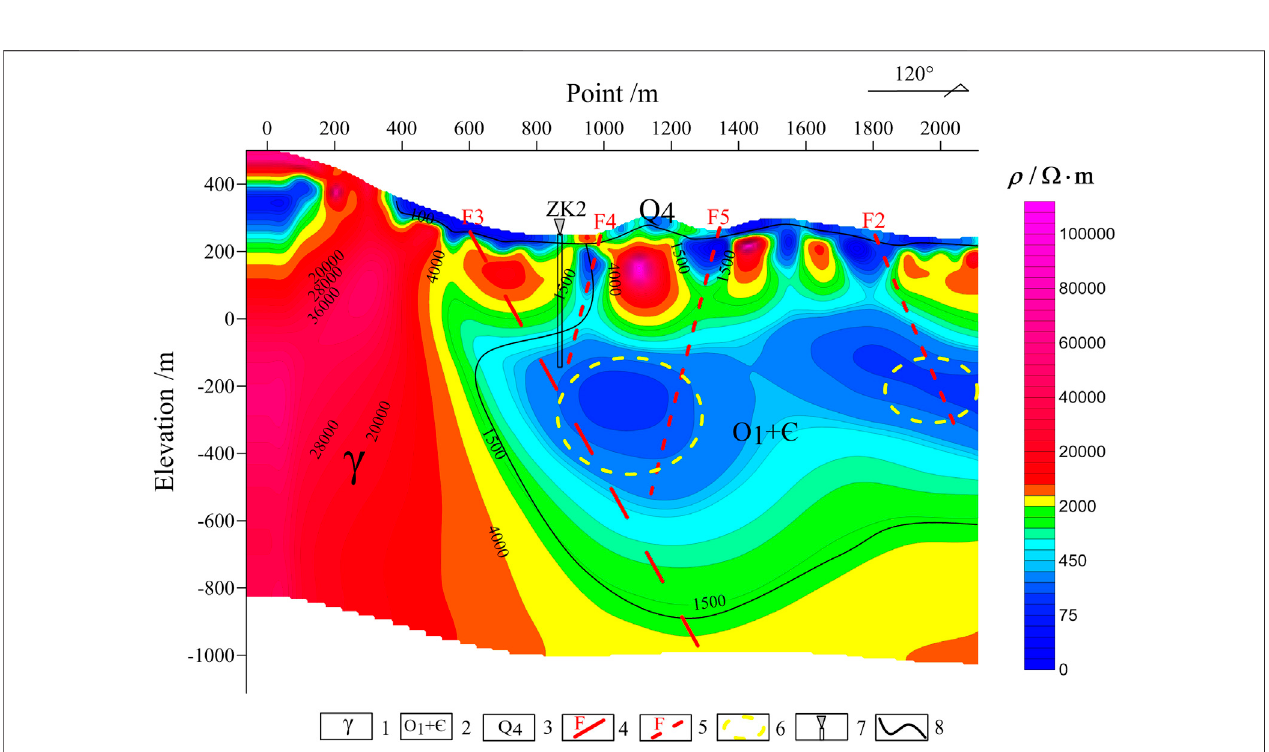
FIGURE 4 | CSAMT integrated interpretation section of survey line L2. 1-Granite; 2-Lower Ordovician-Cambrian; 3-Quaternary; 4-inferred Huangao fault; 5- inferred secondary fault; 6-inferred geothermal reservoir; 7-borehole; 8-inferred contact zone.